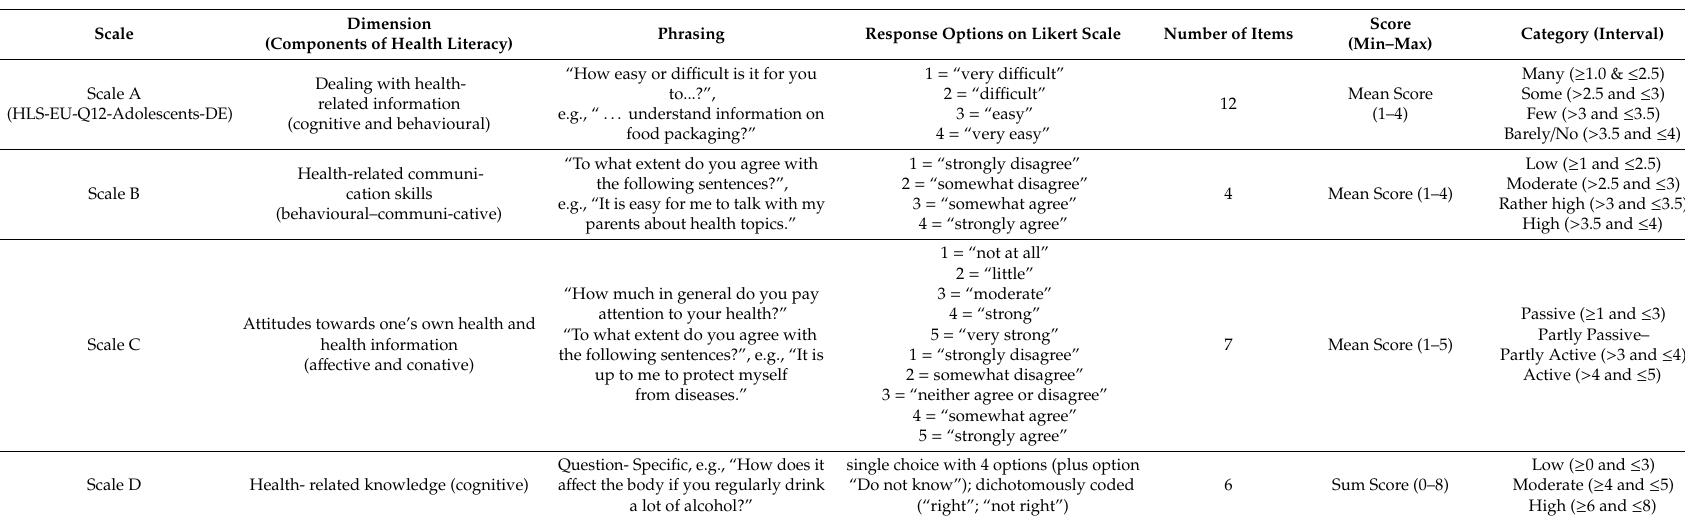
Table 1. Four Scales of the Measurement of Health Literacy Among Adolescents Questionnaire (MOHLAA-Q): dimension, component of health literacy, phrasing, response options on Likert Scales, number of items, score (min-max) and category